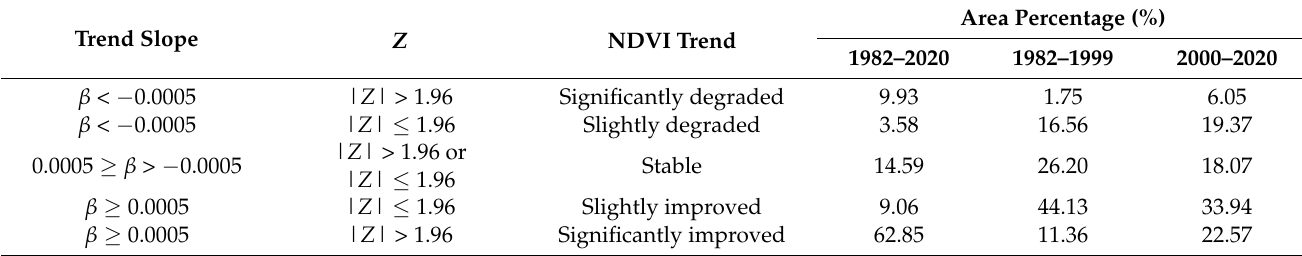
Table 3. Trend of NDVI in the